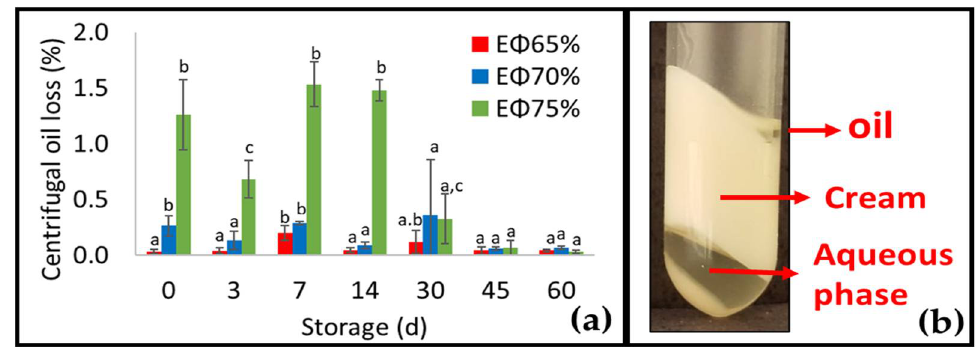
Figure 5. Oil loss upon centrifugation throughout 60 days of storage at 25 °C ( a ) and appearance of samples after centrifugation ( b ). Mean values (mean value ± standard derivation, n = 3) for the same parameter, sample, and column with different lower-case superscripts are significantly different based on Tukey’s test at p < 0.05.